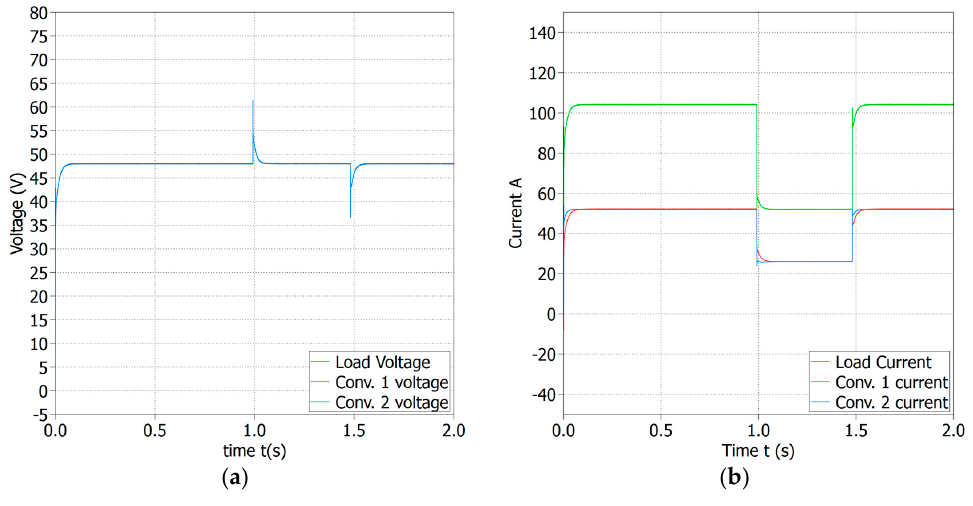
Figure 6. Complete simulation model of parallel Buck converters in DC Microgrid in